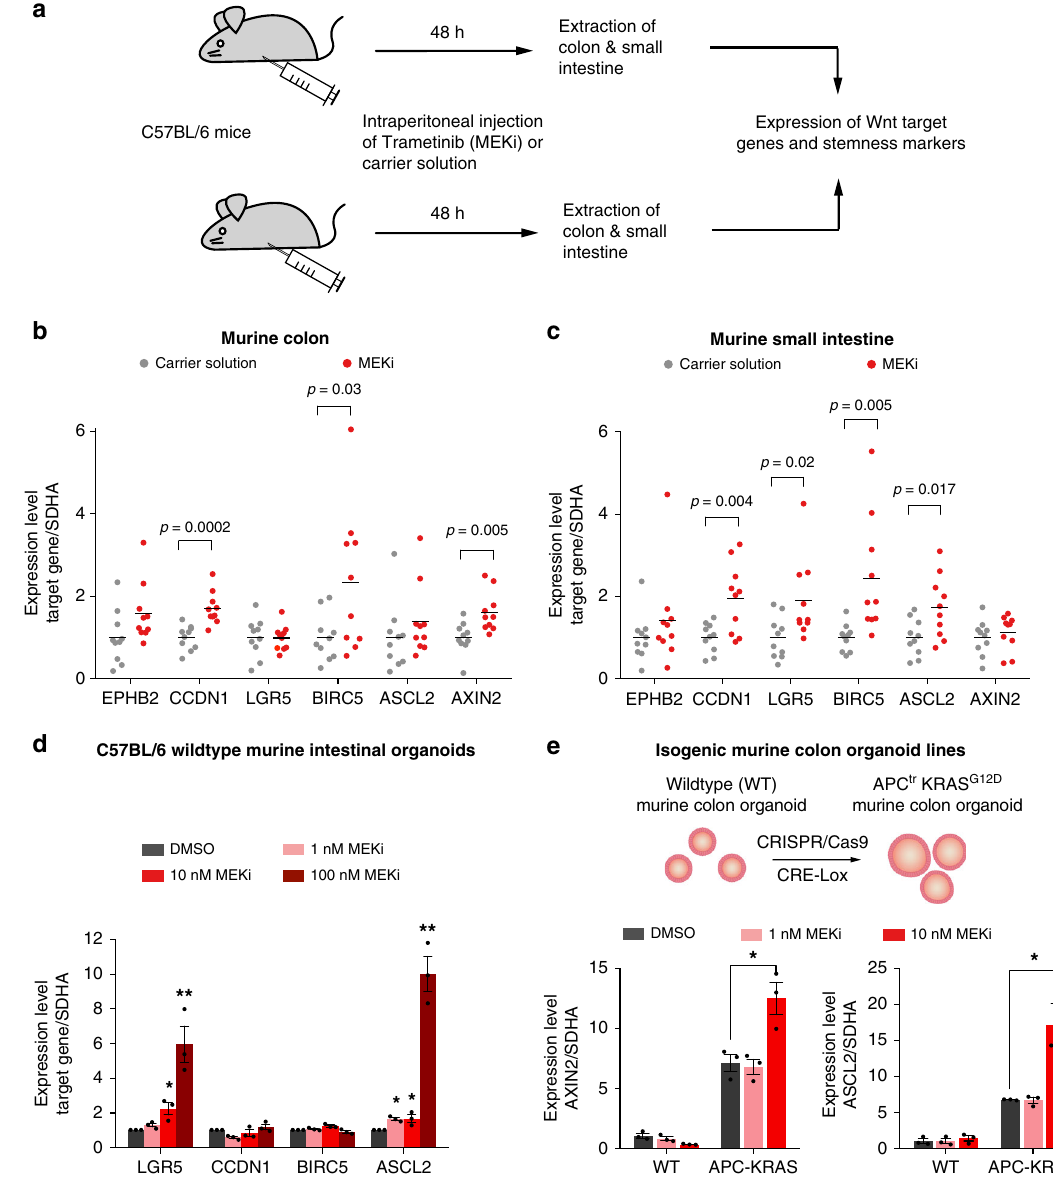
Fig. 6 MEK inhibition activates Wnt target genes in murine intestine. a Schematic overview showing treatment of C57BL/6 mice with the MEK inhibitor trametinib. C57BL/6 mice were treated with either 2 mg kg − 1 body weight of trametinib or carrier solution. Drugs were administered as intraperitoneal injections. 48 h after injection, animals were sacri fi ced and the colon and ileum were isolated and processed for further analysis. b – c Expression of Wnt target genes and stemness markers are increased in the small intestine ( b ) and colon ( c ) of trametinib treated mice. RNA was isolated from tissue of the respective organs and expression levels of target genes were determined by qPCR analysis. Results represent ten animals per treatment group ( fi ve male and fi ve female animals). d Trametinib increases expression of stemness marker in murine intestinal organoids. Intestinal organoids derived from C57BL/6 mouse were treated for 72 h with different concentrations of trametinib and then lysed for RNA isolation and qPCR analysis. Data from three independent experiments are represented as mean ± s.e.m. e Trametinib increases Wnt target gene expression in APC-KRAS mutant colon organoids. Organoids were generated from C57BL/6 lox-STOP-lox KRAS G12D CreERT mice. Isogenic (wildtype and APC-KRAS mutant) organoids lines were generated by in vitro Cre-recombination and genome editing of APC . Treatment of APC-KRAS, but not wild-type organoids, with trametinib for 72 h caused an increase of AXIN2 and ASCL2 expression. Data from three independent experiments are represented as mean ± s.e.m. * p < 0.05, ** p < 0.01, two-sided Student ’ s t